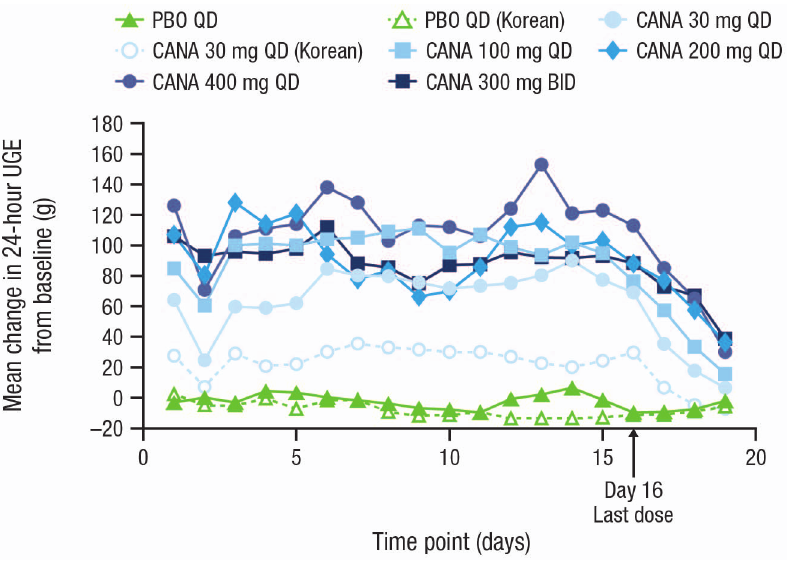
Figure 2. Change from baseline in 24-hour UGE. UGE, urinary glucose excretion; PBO, placebo; CANA, canagliflozin; QD, once daily; BID, twice daily.